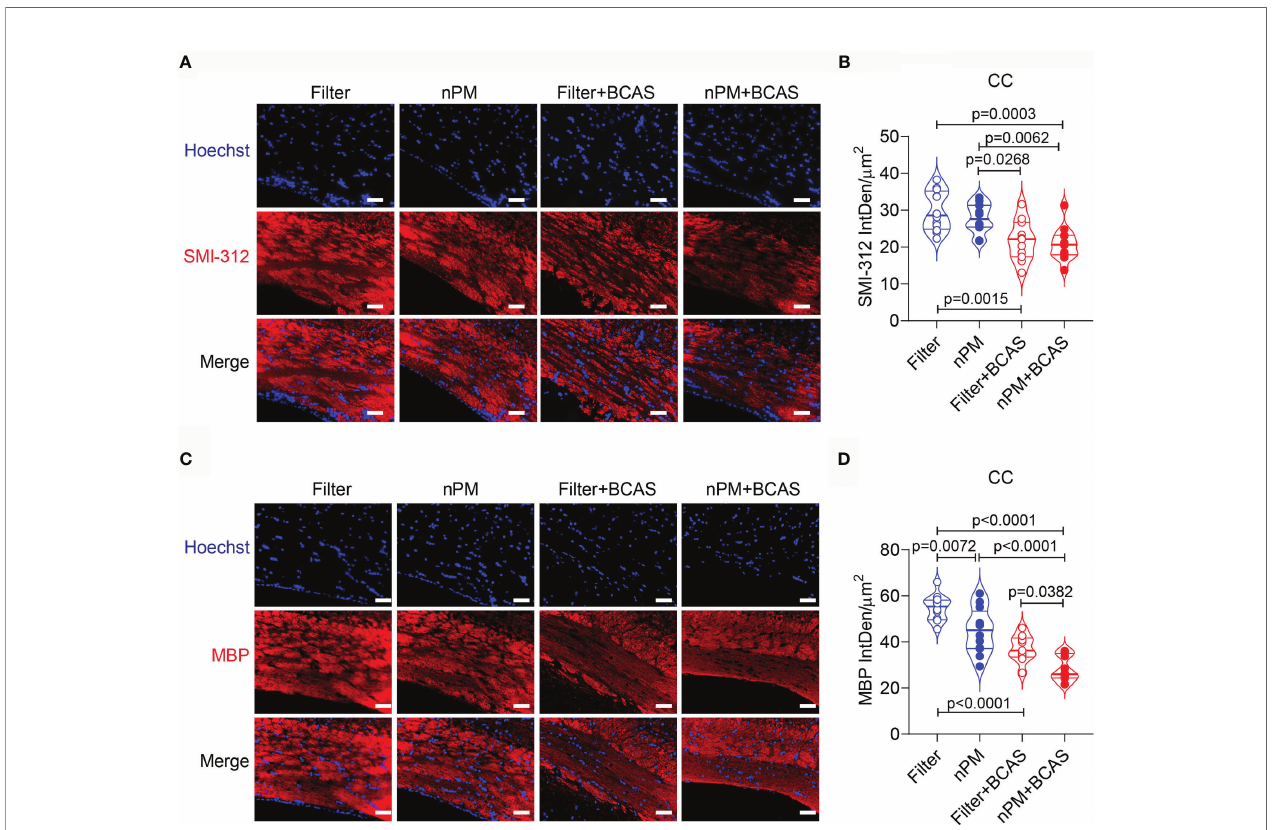
FIGURE 5 | Increased demyelination in white matter of nPM exposed mice. (A) White matter axons were visualized by staining with SMI312 antibody (red) and quanti fi ed in the corpus callosum area (B) . In panel (B) n=12 in fi lter, nPM and nPM+BCAS groups and n=11 in fi lter+BCAS group. (C) White matter myelin was visualized by staining with myelin basic protein (red) antibody and quanti fi ed in the corpus callosum area (D) . In panel (D) n=12 in fi lter, nPM and nPM+BCAS groups and n=9 in fi lter+BCAS group. Data is presented as violin plot with median and quartiles. 1-way ANOVA and Bonferroni Post Hoc tests were used for statistical testing. Scale bars = 50 µm in panels (A, C) . CC, corpus callosum; IntDen, integrated density; MBP, myelin basic